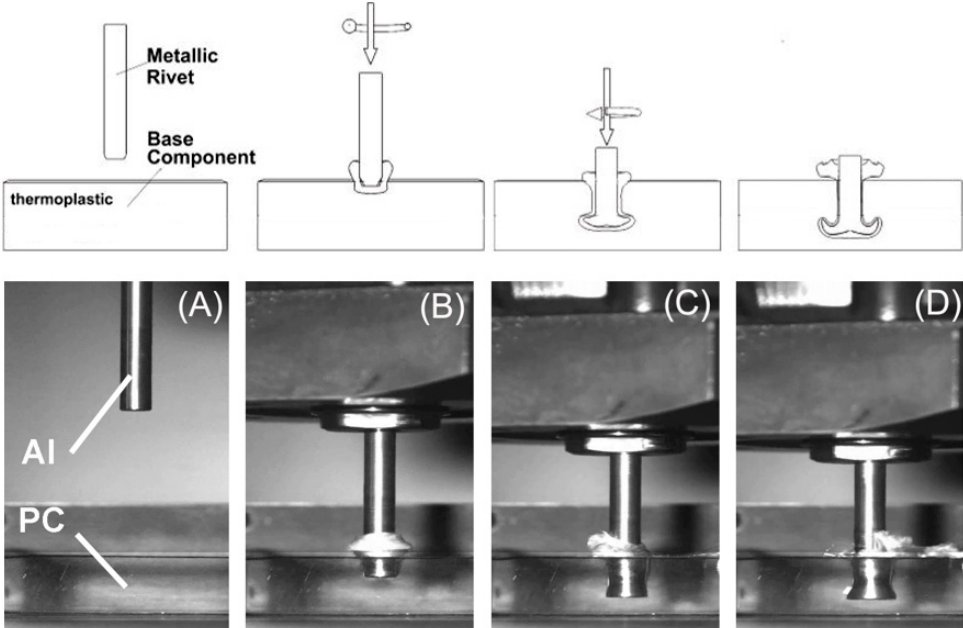
Figure 2. Friction Riveting process steps shown on an aluminum–polycarbonate joint: ( A ) Clamp- ing/positioning of joining partners, ( B ) Rivet rotation and insertion, ( C ) Rivet plastic deformation and forging, ( D ) Joint consolidation/anchoring [7]. Reproduced with permission from [Rodrigues, C.; Blaga, L.; dos Santos, J.; Canto, L.; Hage, E.; Amancio-Filho, S.], [Journal of Materials Processing